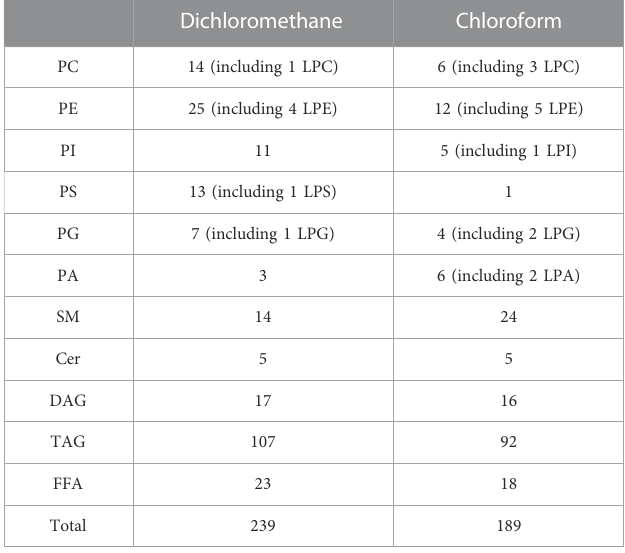
TABLE 1 Species numbers of human milk lipids extracted by different extraction solvents. Dichloromethane